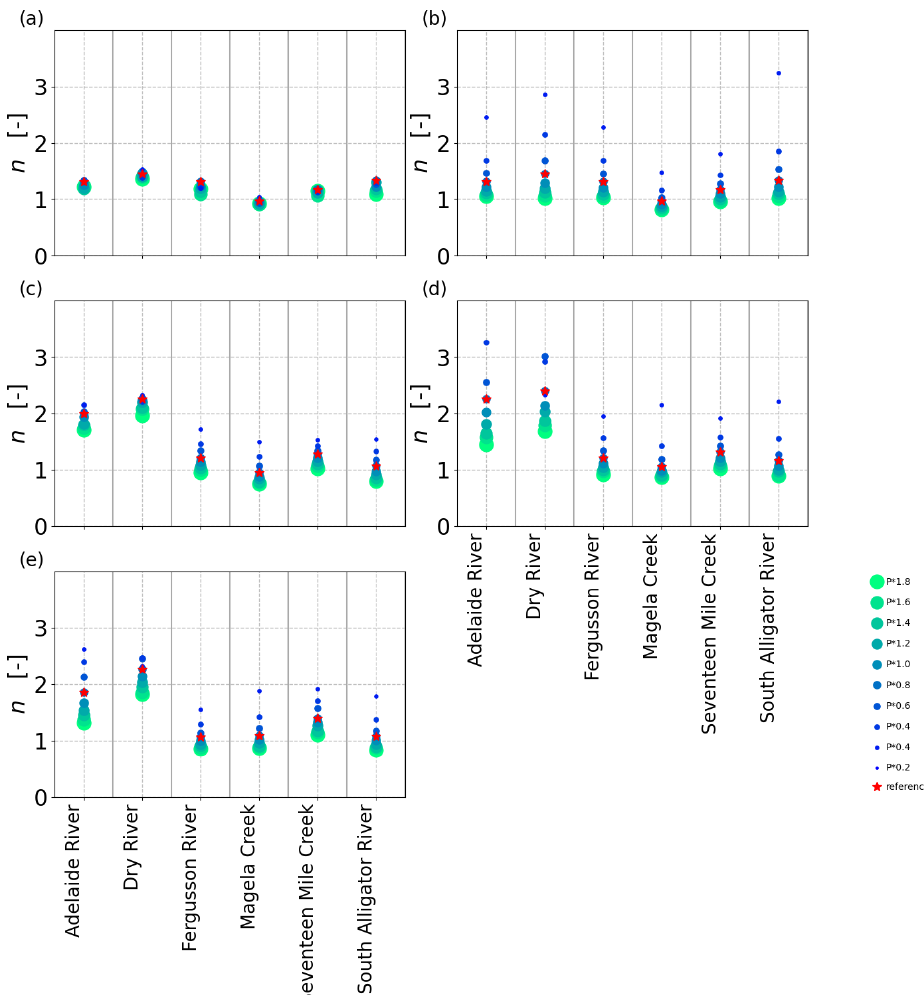
Figure 9. Variability of n in response to changing precipitation in (a) the optimized VOM, (b) the VOM without re-optimization, (c) FLEX, (d) TUWmodel, and (e) GR4J. Fitted n values for six catchments in Australia with unperturbed precipitation (red star) and increased/de- creased precipitation (color